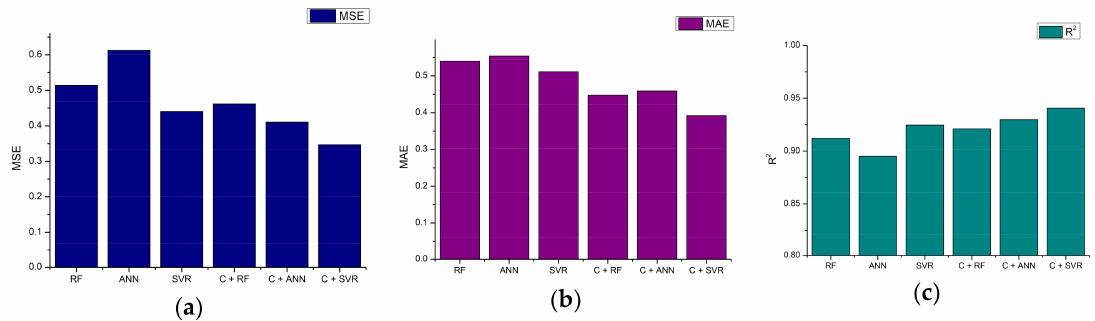
Figure 9. Comparison of predictors based on: ( a ) MSE; ( b ) MAE; ( c ) R 2